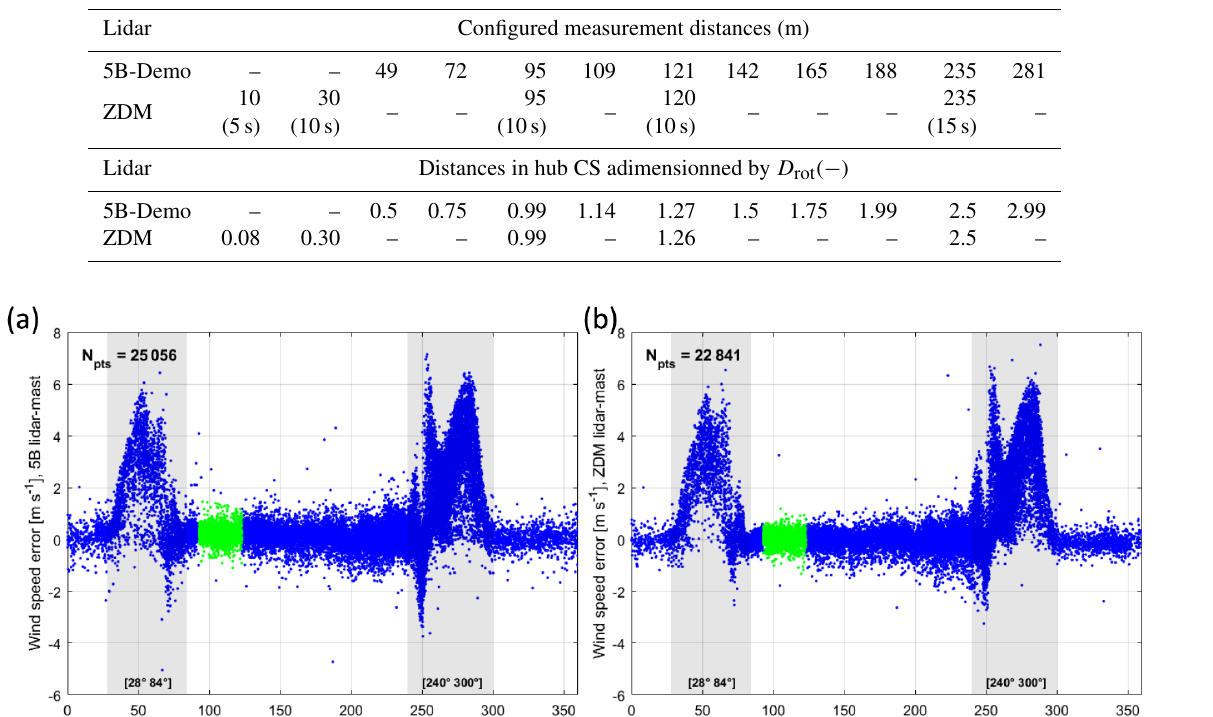
Table 1. Configuration of lidar measurement distances during the Nørrekær Enge campaign.